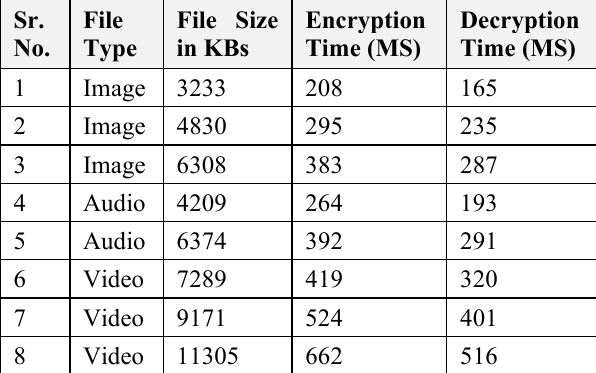
Table 2. Sample data and time taken by the hybrid cryptography algorithm